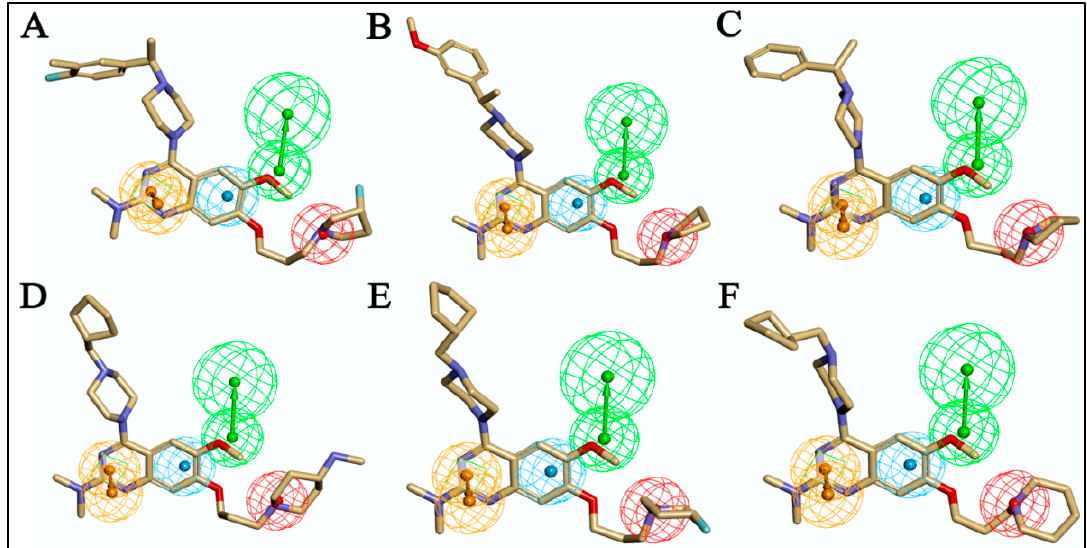
Figure 15. Alignment of six representatives of newly designed molecules on pharmacophore Hypo1: ( A ) T55 , ( B ) T57 , ( C ) T58 , ( D ) T60 , ( E ) T62 , and ( F ) T64.